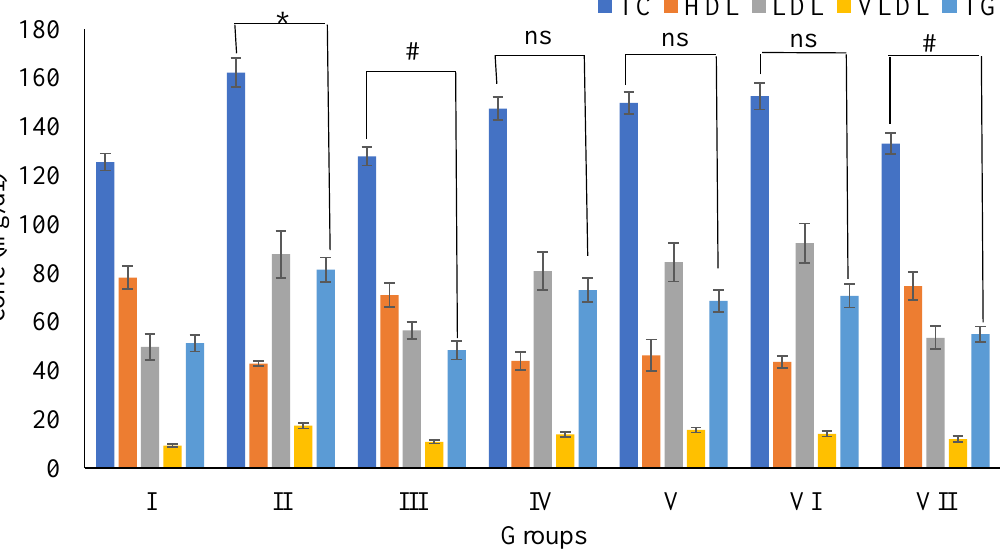
Figure 9. Effects of Wt-F of B. diffusa extract on lipid profile in SD rats after 60 days of treatment. Where TC = Total cholesterol; HDL = High density lipoprotein; LDL = Low density lipoprotein; VLDL = Very low-density lipoprotein; TG = Triglyceride. Data are expressed as Mean ± SEM of 6 rats in each group and p -value = * < 0.01 showed significance compared with respective group I, p -value = # < 0.01 showed significance compared respective with group II and ns = non-significant compared with respective group II.